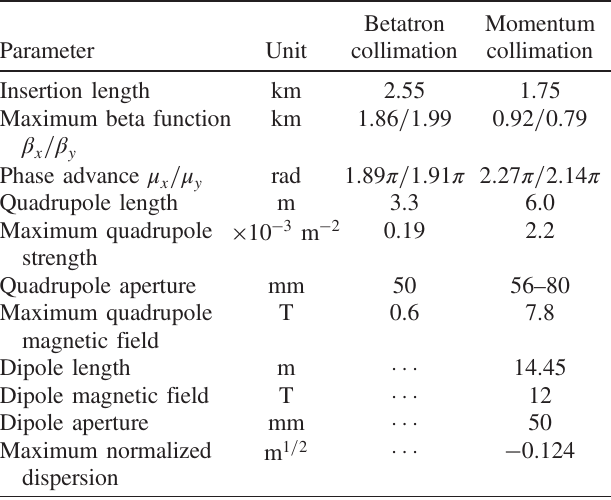
TABLE I. Basic parameters of the collimation insertion in lattice scheme